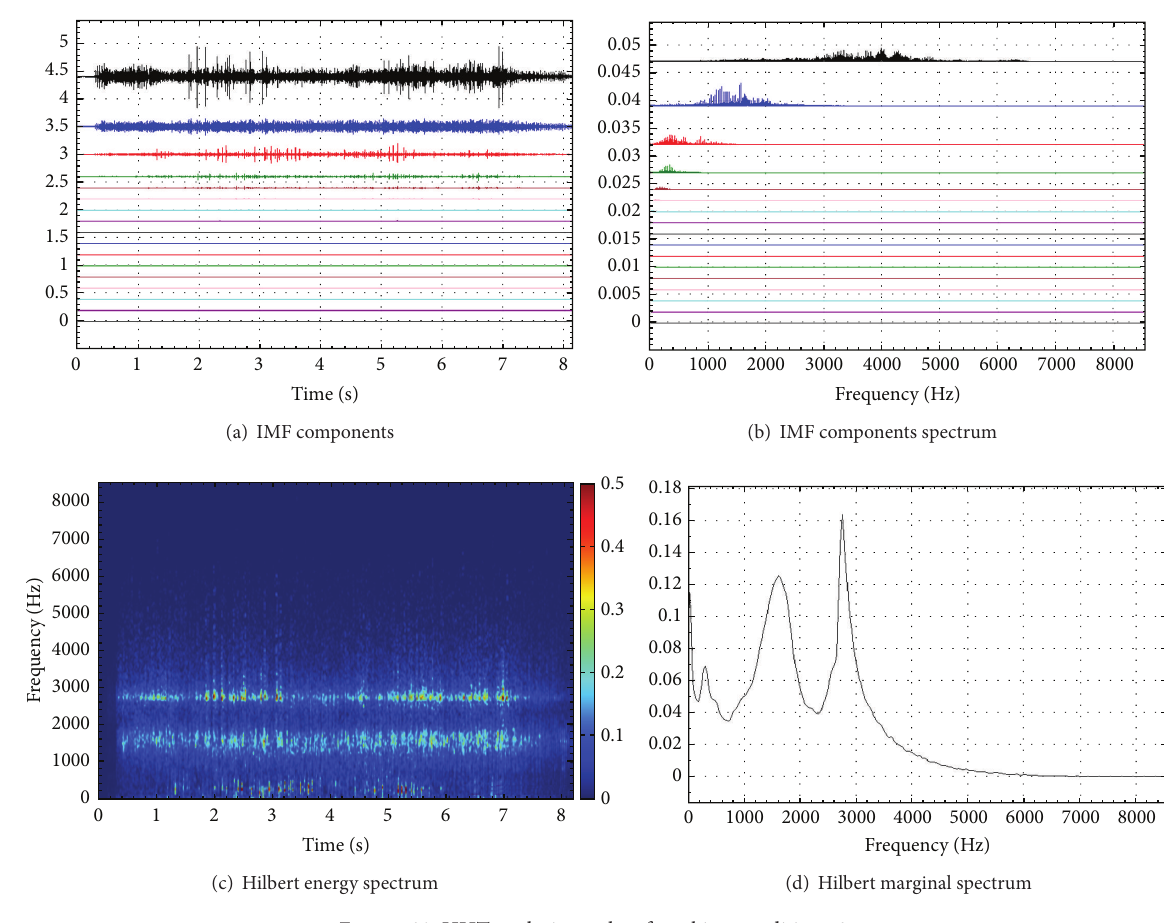
Figure 39: HHT analysis results of working condition